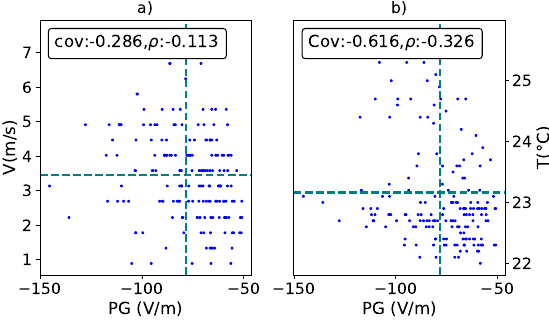
Figure 8: Scatter plots in CASLEO: (a) PG versus wind intensity (1 minute averages), (b) PG versus tempera- ture (1 minute averages). At the top left corner of each panel, the covariance (cov) and correlation coefficient ( rho ) values are presented for each set. The vertical dotted lines correspond to the mean values of the series under